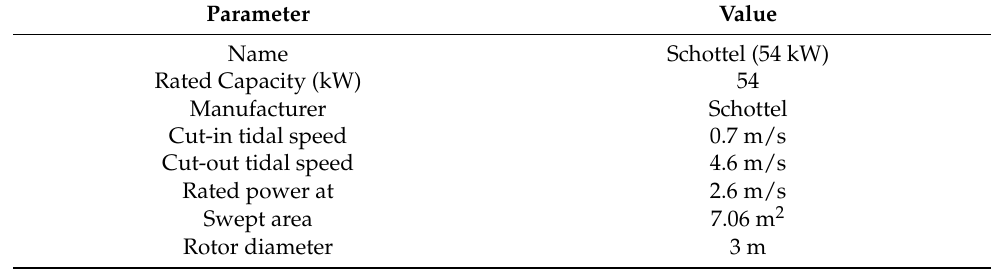
Table 3. Tidal turbine details.